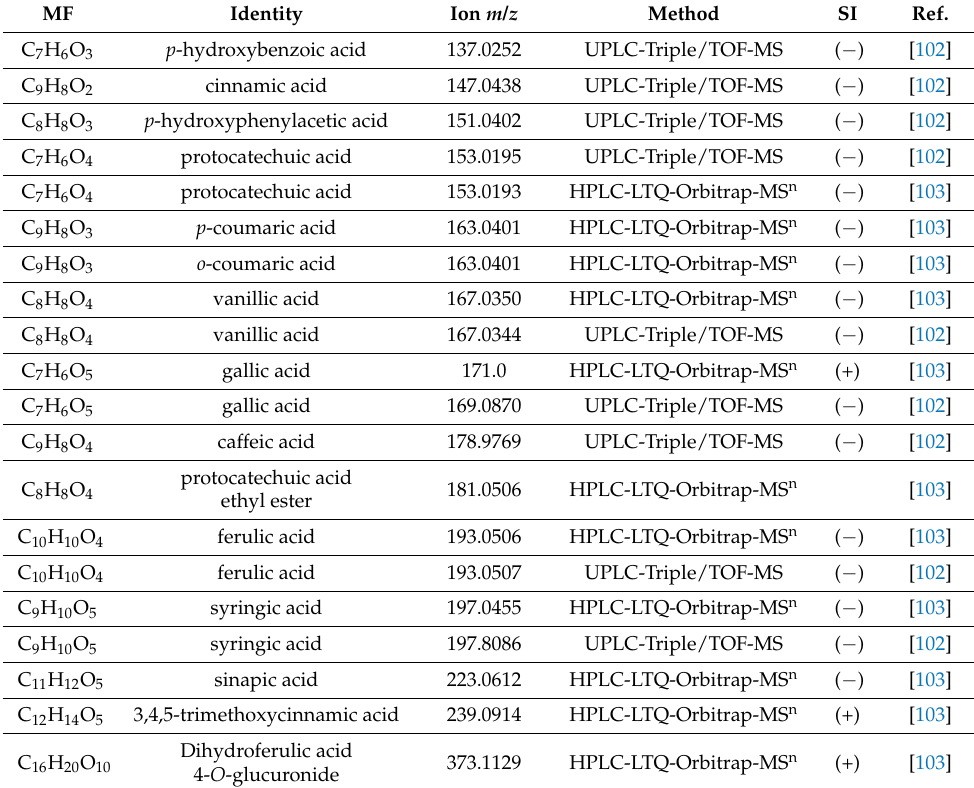
Table 1. Phenolic acids detected in rice using LC and MS-based